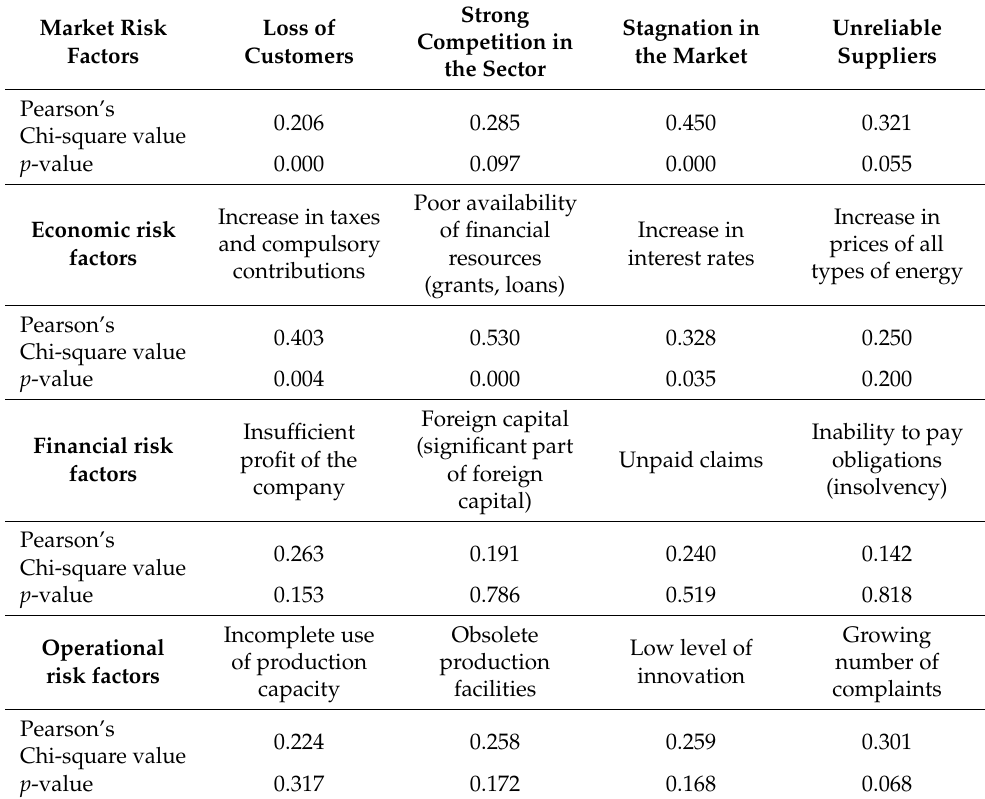
Table 7. The results of the research into the relationships between the intensity of risk and the position responsible for risk management using the Pearson’s Chi-square